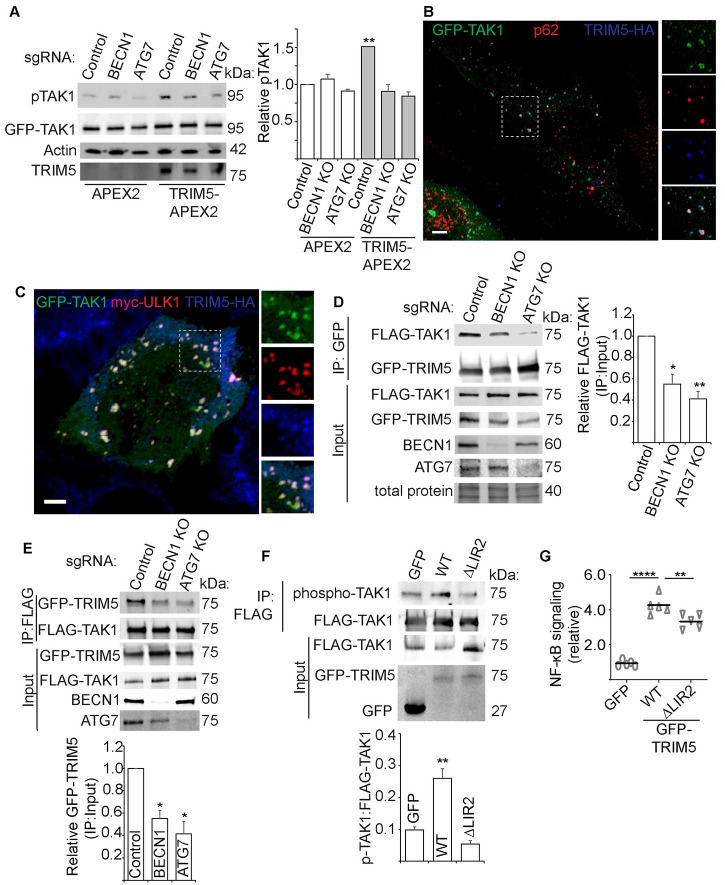
Autophagy factors scaffold TRIM5 interactions with TAK1 and promote TAK1 activation.(A) Immunoblot analysis of the impact of TRIM5 expression on TAK1 activation in control and autophagy factor knockout HEK293T cells. Lysates from cells transiently transfected with GFP-TAK1 and either APEX2-alone or TRIM5-APEX2 were immunoblotted and probed with the indicated antibodies. Right, the abundance of active phospho-TAK1 (phospho-Thr184/187) relative to total GFP-TAK1. N = 3 experiments. (B) Confocal microscopic analysis of GFP-TAK1, TRIM5-HA (rhesus; blue), and endogenous p62 (red) in HeLa cells. Dashed box, region shown in zoomed-in insets. Scale bar, 5 μm. (C) Confocal microscopic analysis of GFP-TAK1, Myc-ULK1 (red) in HeLa cells that stably express TRIM5-HA (blue). Dashed box, indicates regions shown in zoomed-in insets (right). Scale bar, 5 μm. (D, E) Co-immunoprecipitation analysis of interactions between FLAG-TAK1 and GFP-TRIM5 in WT and autophagy factor KO cells. GFP-TRIM5 was immunoprecipitated in (D) and FLAG-TAK1 was immunoprecipitated in (E). Plots show the abundance of the immunoprecipitated protein (FLAG-TAK1 in D and GFP-TRIM5 in E) relative to that protein’s abundance in the input. N = 3 independent experiments. (F) Immunoblot analysis of the impact of WT or LIR2 mutant (WE196AA) TRIM5 on the abundance of active phospho-TAK1 (phospho-Thr184/187). Plot shows the abundance of phospho-TAK1 relative to that of FLAG-TAK1. N = 3 independent experiments. (G) The impact of WT or LIR2 mutant TRIM5 on the activation of an NF-κB luciferase reporter. Each data point represents an independent biological replicate. *, P < 0.05; **, P < 0.01; ****, P < 0.0001 by ANOVA.